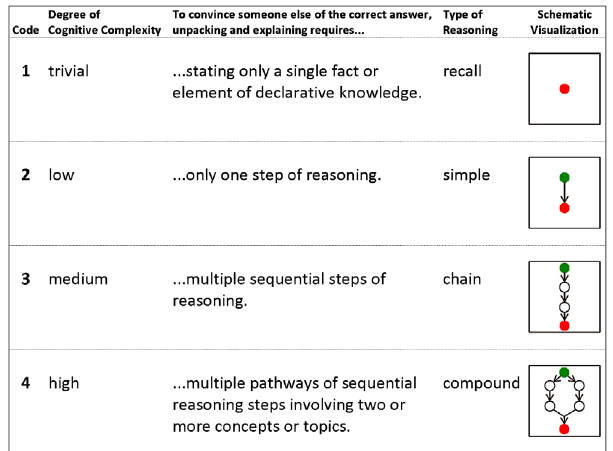
FIG. 1. The question complexity rubric used to code the level of cognitive complexity required to unpack and defend the solution to a question, problem, etc.